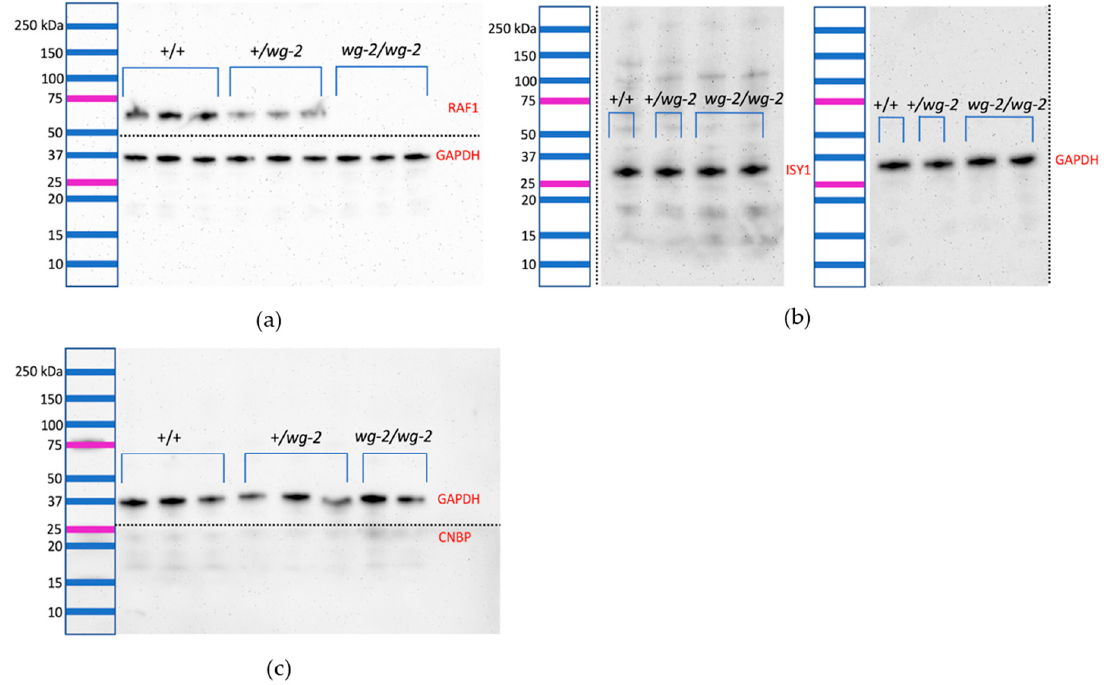
Figure 3. Western blots of RNA-expressed genes ( RAF1 , CNBP , ISY1 ) to detect protein in embryos (Stage 36 HH) of the three genotypes of the Wingless-2.331 line show that wg-2 / wg-2 mutant embryos lack RAF1 protein expression. Precision Plus Protein Dual Color standards (Bio-Rad; Hercules, CA, USA) are shown at the left to indicate the approximate size of the bands. Dotted lines indicate cuts made in the PVDF membrane in order to incubate pieces separately using di ff erent primary antibodies. In total, n = 12 individuals (four each of: wild-type, carrier, and mutant) were examined for RAF1, ISY1, and CNBP protein expression as compared to GAPDH. Three technical replicates for each individual were performed. ( a ) shows a representative image of two biological replicates of each genotype with bands for RAF1 (above the dotted line, 73 kDa) and GAPDH (below the dotted line, 35 kDa). The average ratio of RAF1 expression compared to GAPDH in wild-type in this blot was 2.08, whereas this ratio was 0.91 in carriers and zero in mutants (calculated using ImageJ software, Version 1.51). This supports the visual assessment that carriers have roughly half the RAF1 expression of wild-type individuals. ( b ) shows a representative image of a wild-type, carrier, and two mutant individuals with bands for ISY1 (left blot, 33 kDa) and GAPDH (right blot, 35 kDa). Expression appears equivalent across samples, and ImageJ for this blot was used to calculate an ISY1 / GAPDH ratio of 0.95 for wild-type, 1.13 for carrier, and 1.00 for the average of the two mutants. ( c ) shows a representative image of three wild-type, three carrier, and two mutant individuals for CNBP (bottom, 19 kDa) and GAPDH (top, 35 kDa). A strong band did not appear for CNBP even at high concentrations of primary antibody, and the faint band at the predicted weight (19 kDa) did not register above the background in most lanes, as analyzed by ImageJ.